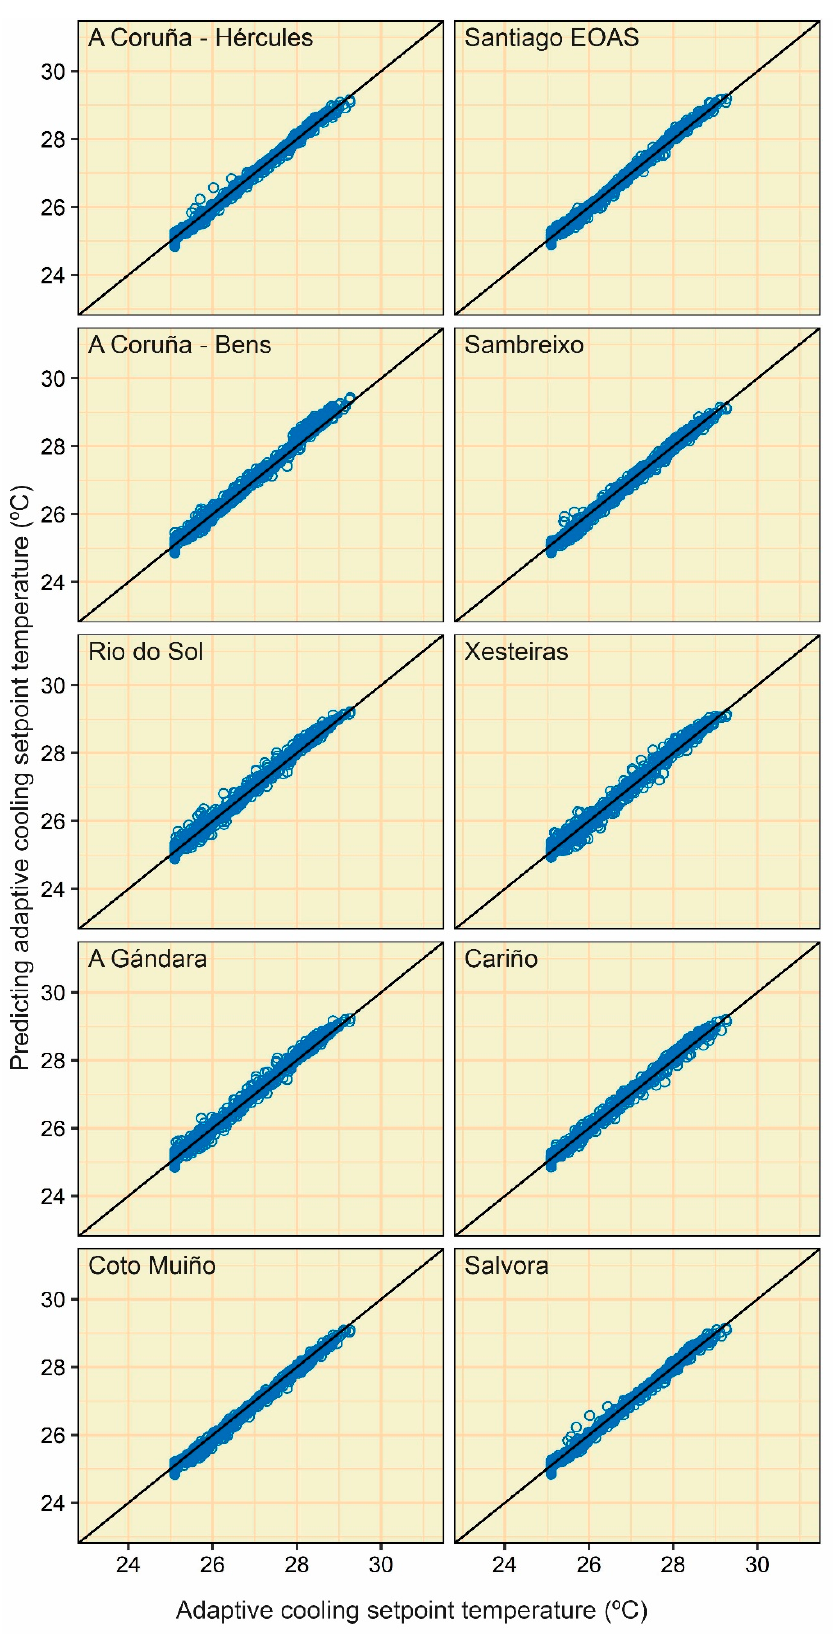
Figure A5. Point clouds between the actual and predicting adaptive cooling setpoint temperature values (category II) of the MLP (approach 1).